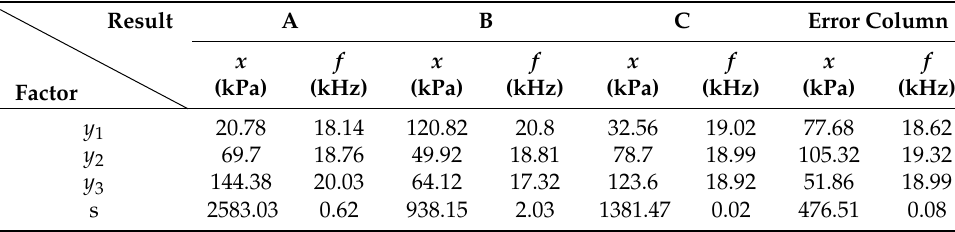
Table 5. The sum of squared deviations of each